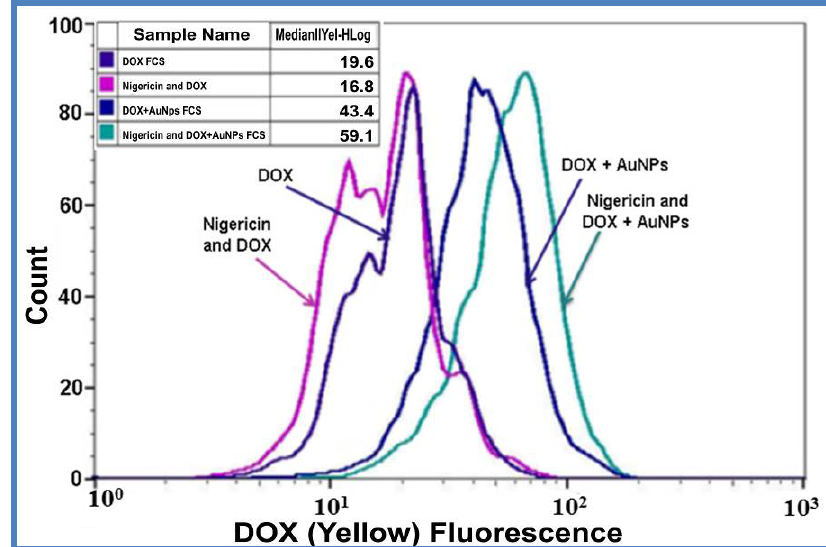
Figure 6. Nigericin induced acidification and effect on uptake of free DOX and DOX loaded AuNPs uptake by Hela cells in vivo . Cellular uptake of DOX and DOX loaded AuNPs by HeLa cells after intracellular acidic environment created by 2.5 µM Nigericin, as measured by Millipore Guava 8HT easycyte flowcytometer after 30 min incubation. Inset image shows DOX Median Fluorescence Intensity (MFI) values. The data is representative of two independent